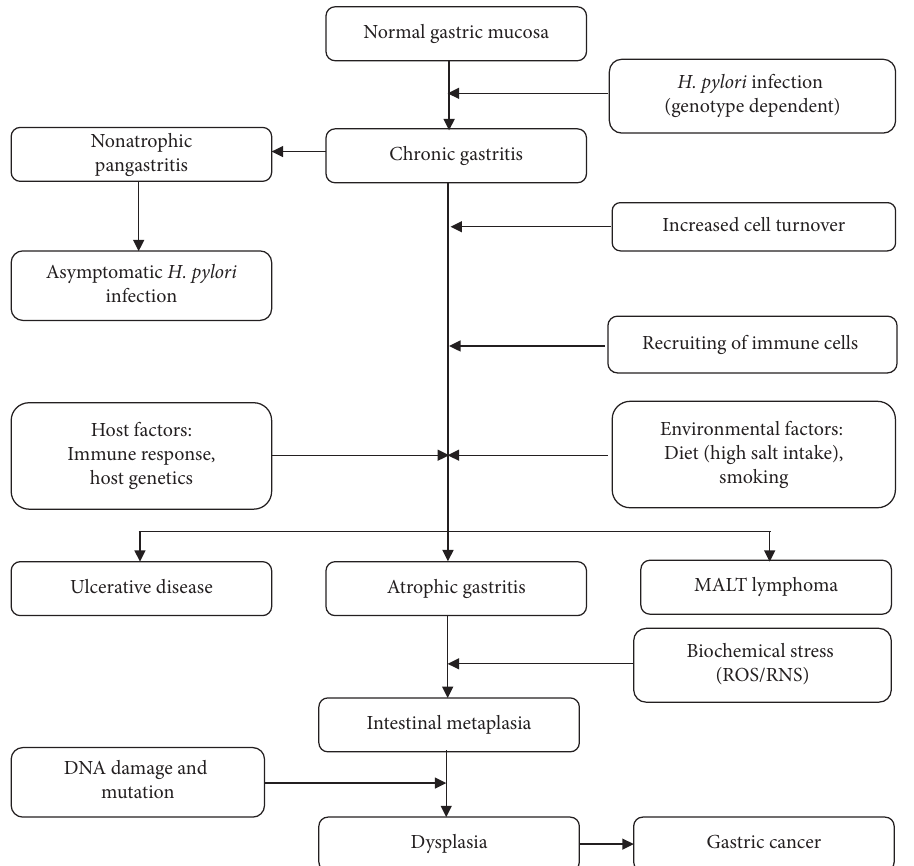
Figure 1: Schematic representation of the causative factors of gastric cancer and diseases induced by H . pylori